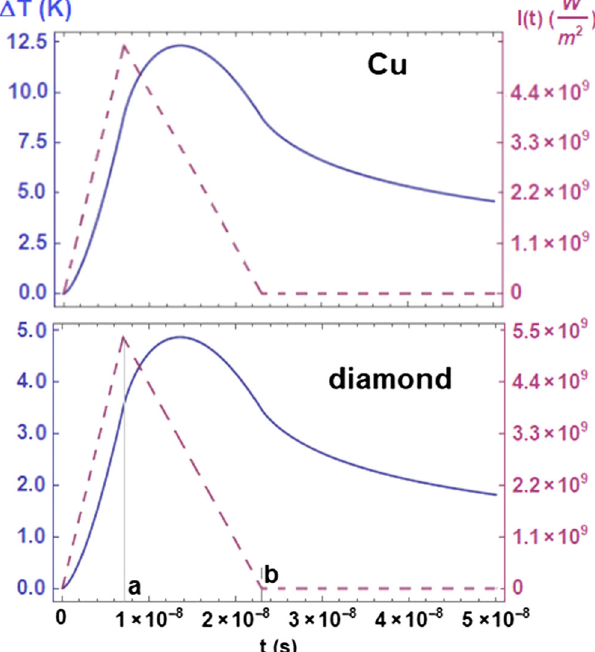
FIG. 4. Temporal evolution of the cathode surface temperature (blue trace) and the laser irradiance (dashed burgundy trace), approximated by a triangular piecewise function.